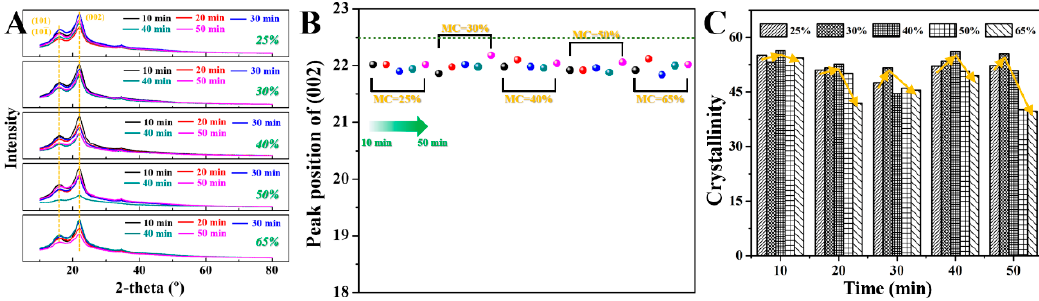
Figure 1. ( A ) The XRD curves of the bamboo slices after 180 ◦ C saturated steam heat treatment. The corresponding di ff raction peak location of cellulose (002) plane ( B ), and relative crystallinities ( C ) of bamboo slices with di ff erent initial moisture contents and heat treatment